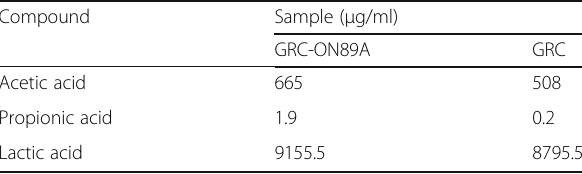
Table 2 The SCFA (acetic acid, propionic acid, lactic acid) content in GRC-ON89A and GRC Compound Sample ( μ g/ml) GRC-ON89A GRC Acetic acid 665 508 Propionic acid 1.9 9155.5